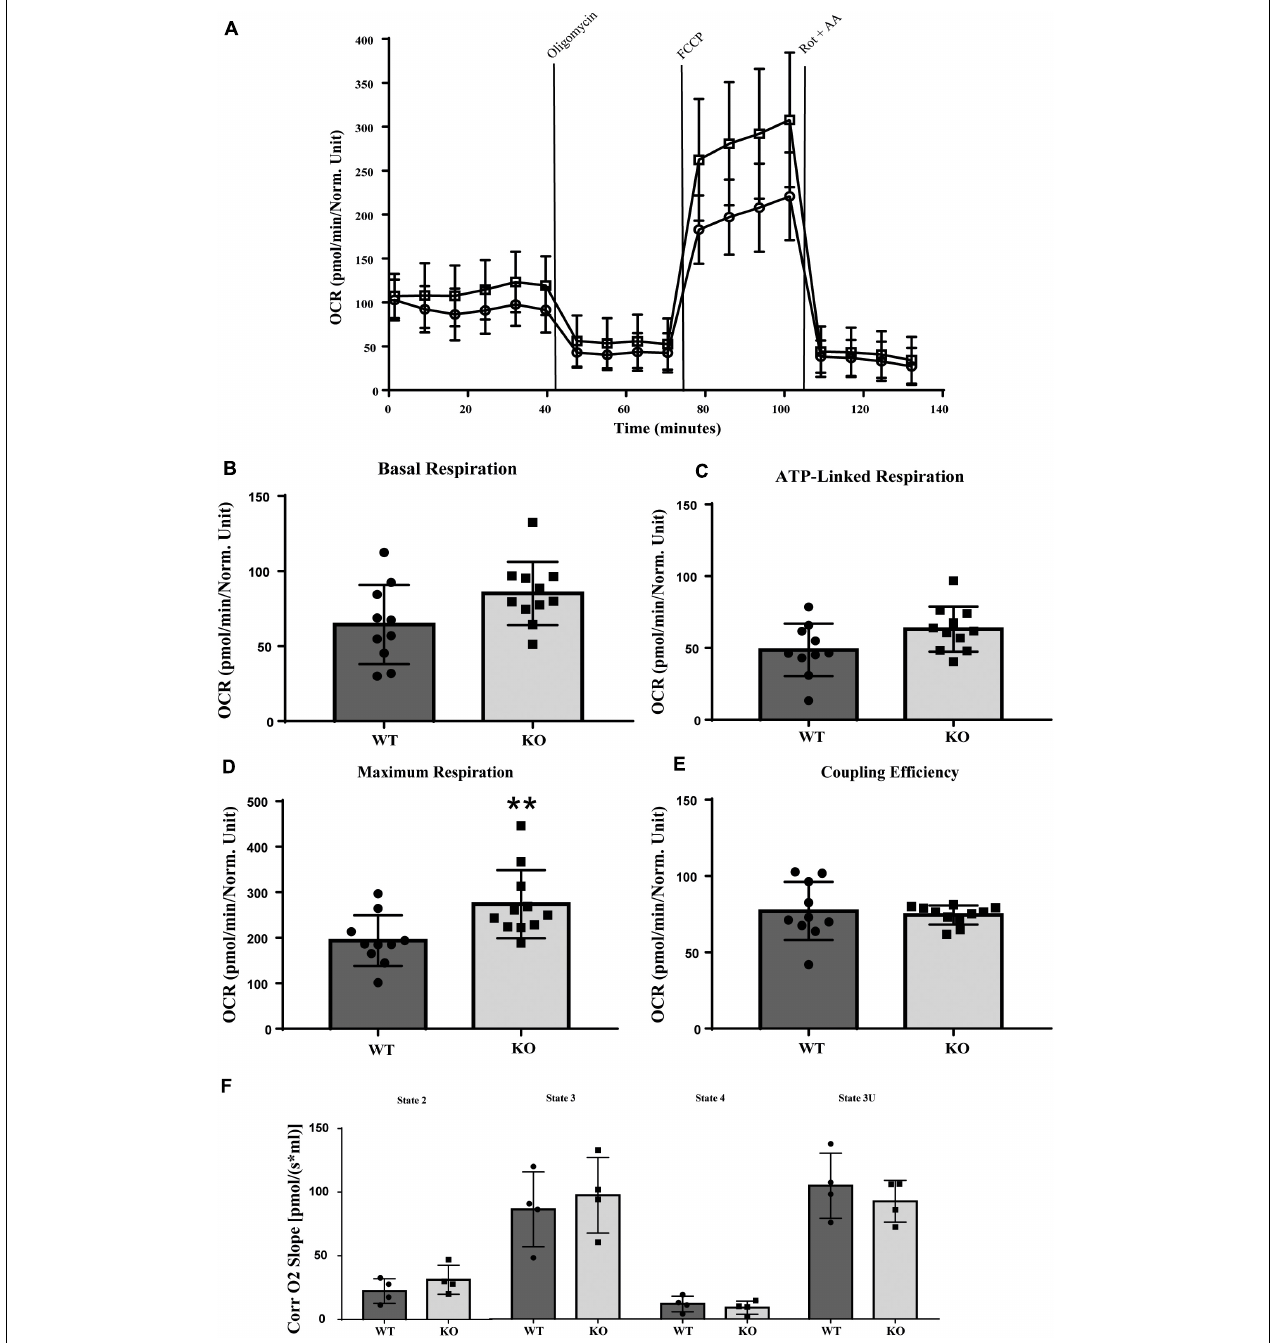
FIGURE 4 | Mitochondrial respirometry measurement in RAW 264.7 cells. LRRK2 KO RAW 264.7 cells have significantly higher maximum OCR in intact cells compared to LRRK2 parental RAW 264.7 cells while in isolated mitochondria the mitochondrial respiration is not altered. (A) Line graph of the OCR values of LRRK2 parental (closed circle) and KO RAW 264.7 (open square) cells in a representative seahorse measurement in intact cells. (B–E) Bar graphs showing different mitochondrial respiratory parameters for LRRK2 parental (black bar) and KO RAW 264.7 (gray bar) derived from the seahorse analysis. Data are represented as mean ± SD and statistical significance was computed using unpaired t -test or Mann-Whitney test. Data shown are representative of 10- 11 different wells/condition and the experiment was repeated at least three times with individual LRRK2 parental RAW 264.7 and LRRK2 KO RAW 264.7 macrophage cells. P -values indicating statistically significant differences between the mean values compared to the WT control with ** p < 0.01. (F) Corrected oxygen slope of different mitochondrial respiration states of LRRK2 parental (black bar) and KO RAW 264.7 (gray bar) cells revealing no significant differences in the mitochondrial respiration states in isolated mitochondrial fraction. Four independent experiments were performed and 3–4 measurements/cell line were measured in each experiment. Data are shown as mean ± SD of the average of four experiments.